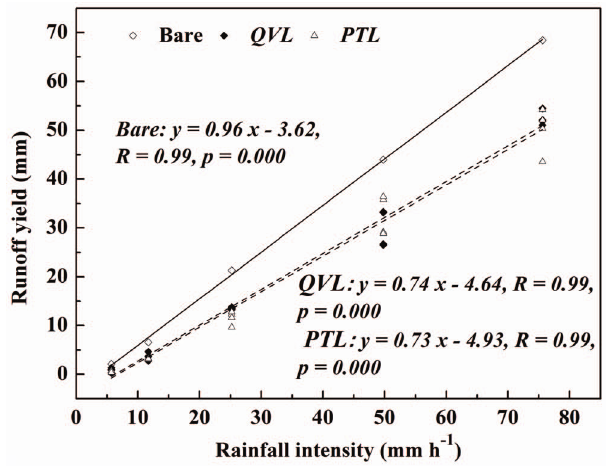
Figure 5. Runoff yield versus rainfall intensity for bare-soil plots (open diamonds), Quercus variabilis litter (closed dia- monds), and Pinustabulaeformis litter (open triangles) for four litter